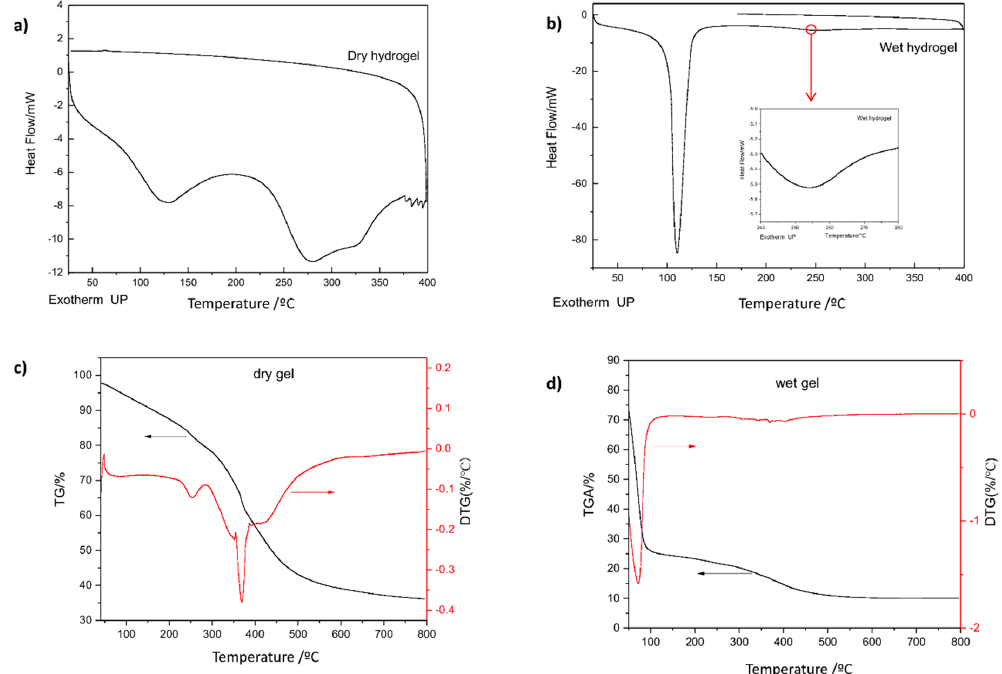
Figure 8. DSC curves of hydrogel based on two monomers: AA (acrylic acid) and DMAA ( N , N - dimethylacrylamide), at wet and dry state: ( a , b ) DSC for dry and wet hydrogel, respectively; ( c , d ) TGA for dry and wet hydrogel, respectively.